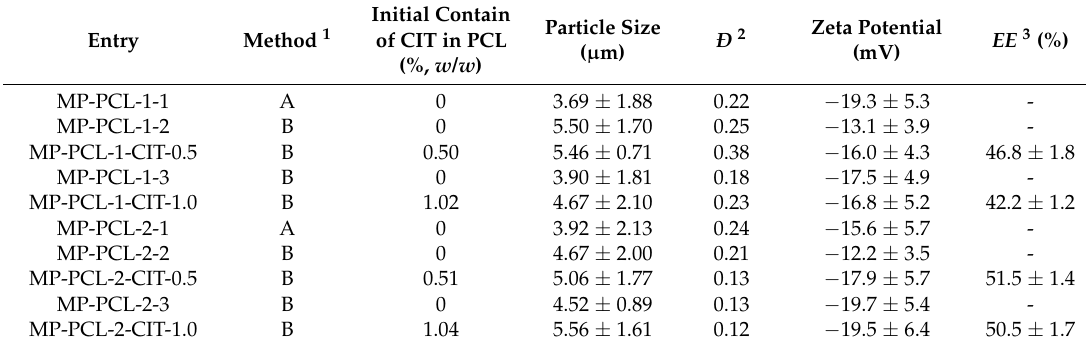
Table 2. Characterization of PCLs